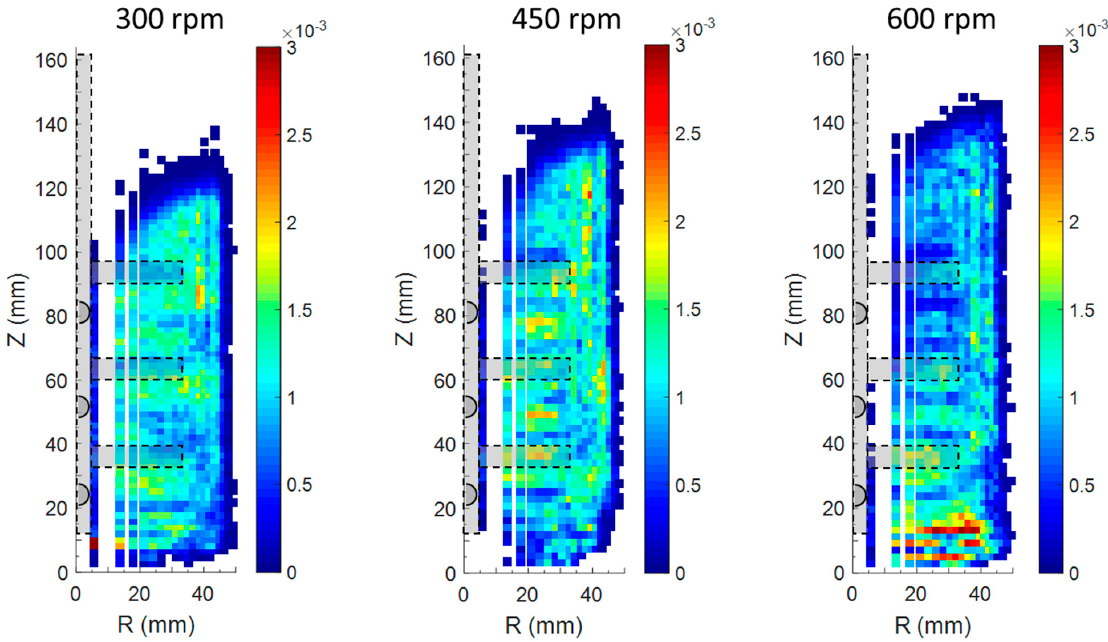
Figure 6. PEPT normalised tracer occupancy plot at the impeller speed of 300 rpm, 450 rpm and 600 rpm. Test case using the bead loading of 2.4 kg and the bottom clearance of 12.7 mm.